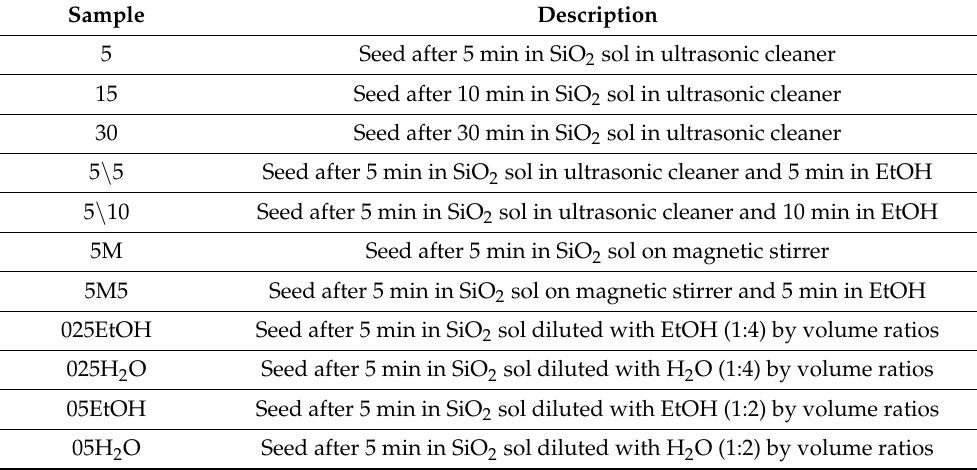
Table 1. Samples of pea seeds coated with SiO 2 sol in different